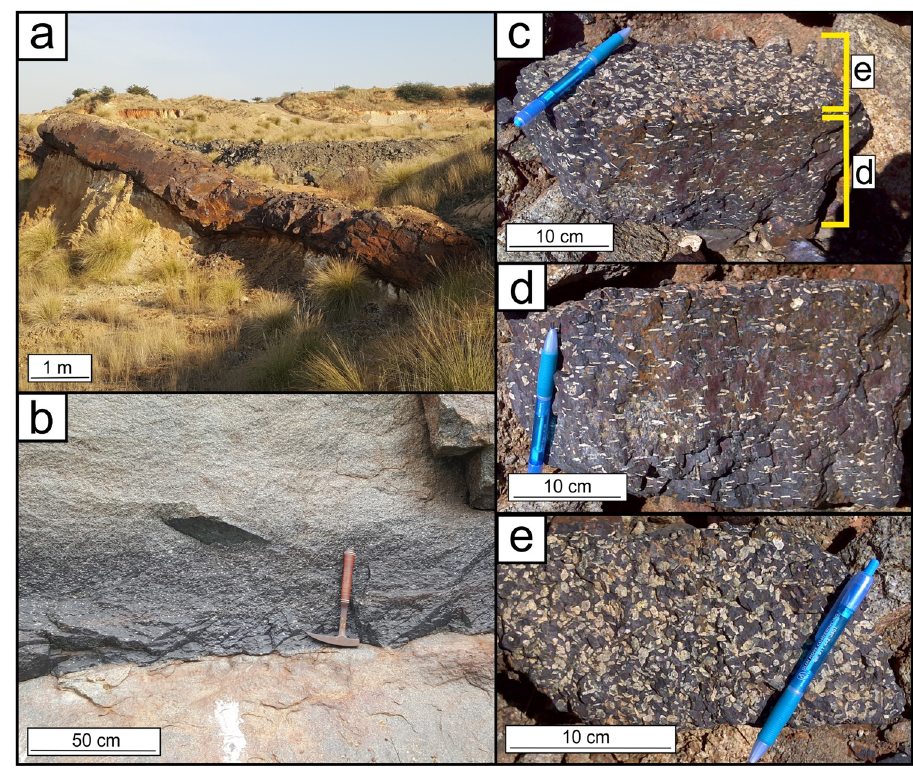
Fig. 2 Appearance of magnetitite layers from the Bushveld Complex. a An exposure of the main magnetite layer (MML) from the Rhovan mine in the Western Limb providing a three-dimensional perspective on the appearance of the layer. The layer is about 1 m thick. b Magnetitite Layer 1 from Magnet Heights in the Eastern Limb located about 2 m above the MML. The layer displays remarkable modal layering as it grades into overlying magnetite – anorthosite via non-cotectic proportions of plagioclase and magnetite. Notice the light-colored anorthositic footwall. Hammer is 40 cm in length. c A sample of a magnetitite layer containing plagioclase grains from the Mapochs Mine in the Western Limb. d The same sample as ( c ) viewed from the side to demonstrate the well-foliated nature of the plagioclase. e The same sample viewed from above. Plagioclase grains appear more equant, and no lineation is evident from visual